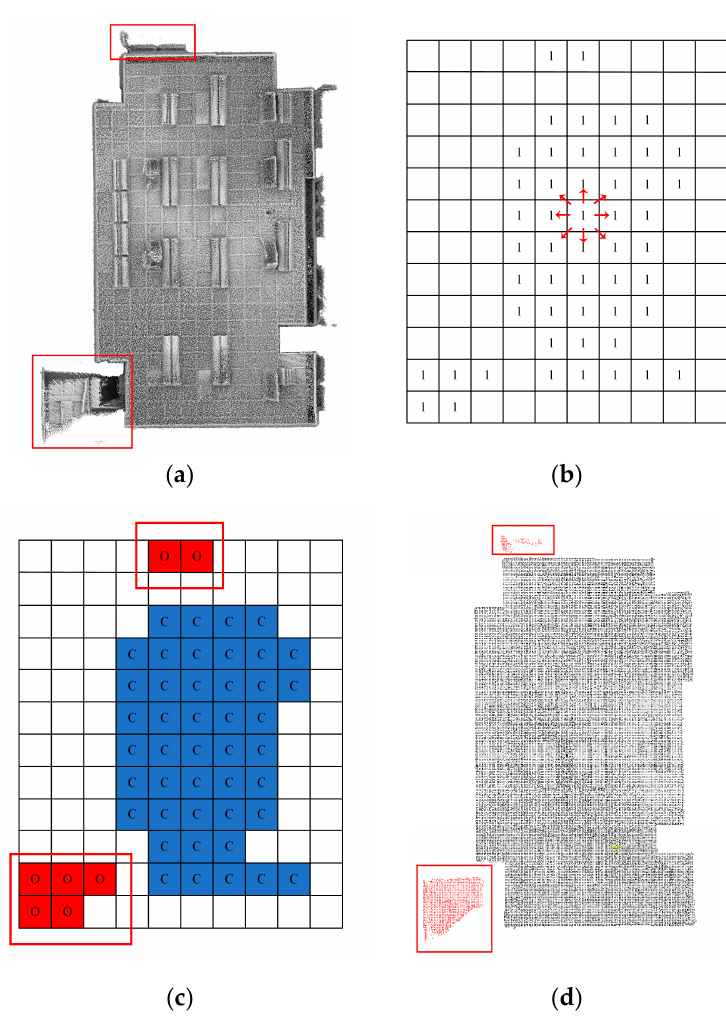
Figure 3. Analysis of detected ceiling surface: ( a ) raw point cloud dataset for visualization of the outlier, ( b ) binary map of ceiling part points (“1” for the grid’s value, the red arrow for the process of eight-connected domain algorithm), ( c ) region map of ceiling part points (“C” for the ceiling grid, “O” for the grid of outliers), ( d ) detected ceiling segment after outlier removal (red points are the outliers).